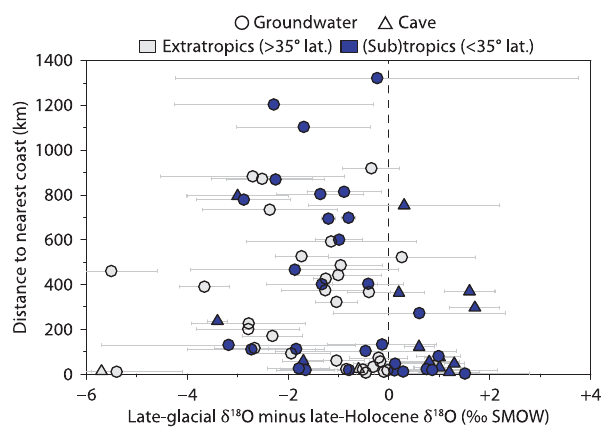
Figure 4. Measured (cid:49) 18 O late-glacial value variability with dis- tance to the nearest coast ( (cid:49) 18 O late-glacial = δ 18 O late-glacial − δ 18 O late-Holocene ). Tropical and subtropical locations are shown in deep blue (<35 ◦ absolute latitude), extra-tropical sites are shown in light grey (>35 ◦ absolute latitude). The shape of each point cor- responds to groundwater and ground ice (circles) or cave calcite (i.e., speleothems; triangles). Error bars mark one standard devia- tion from the